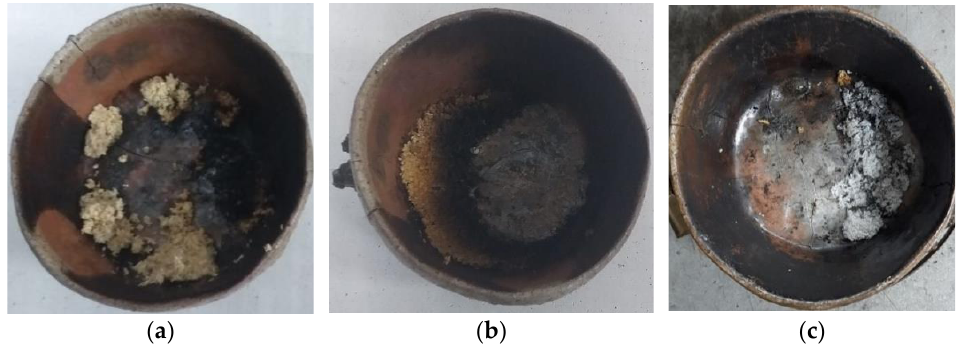
Figure 6. Solid residue after microwave pyrolysis of biomass with different options for the initial distribution of a sample in the crucible: along the edges ( a ); uniform distribution over the entire crucible bottom ( b ); on half of the crucible bottom ( c ).